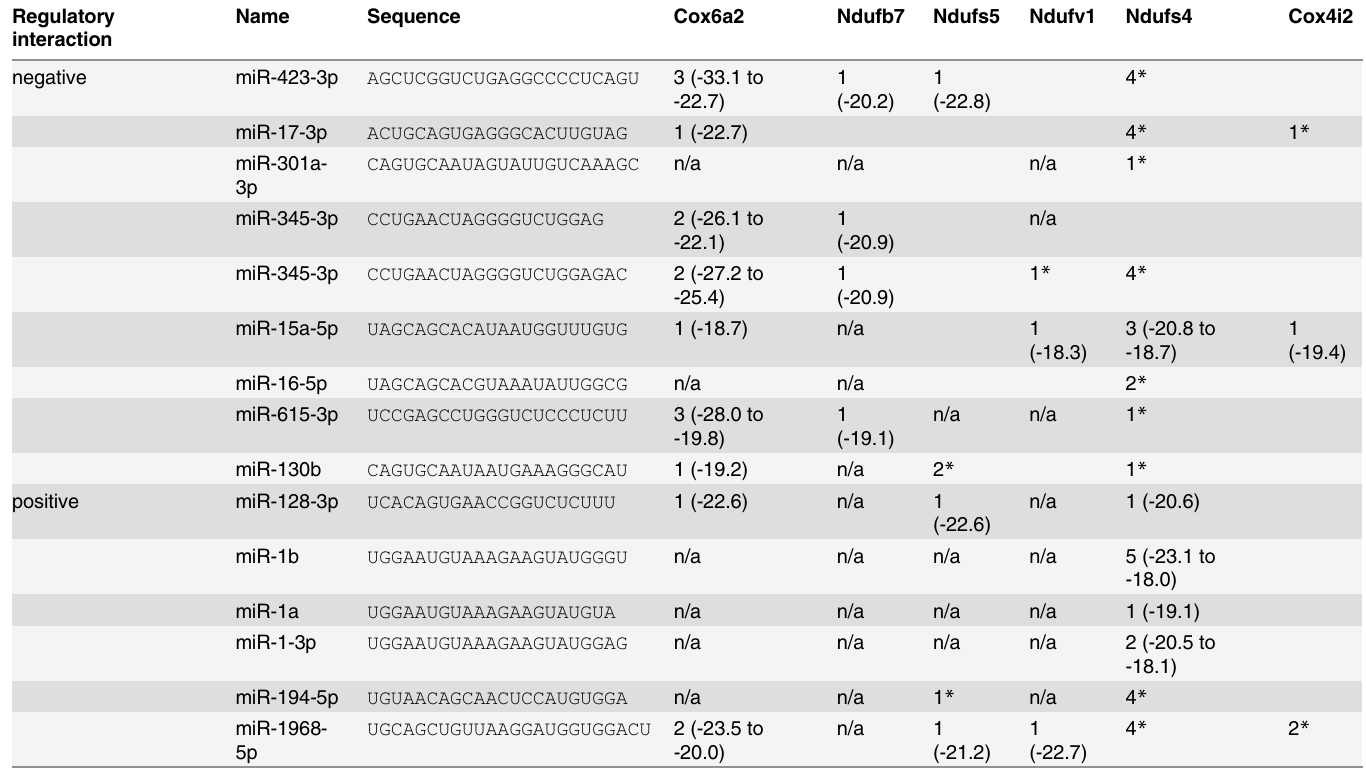
Table 2. Predicted binding sites for miRNAs in the 3 0 -UTRs of their correlated mRNAs (RNAhybrid). Regulatory